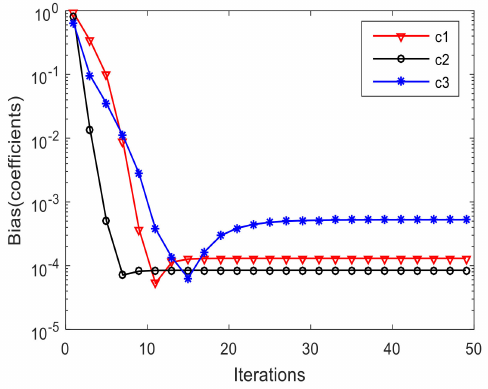
Figure 6. Variation of the estimated MC coefficients versus the iteration